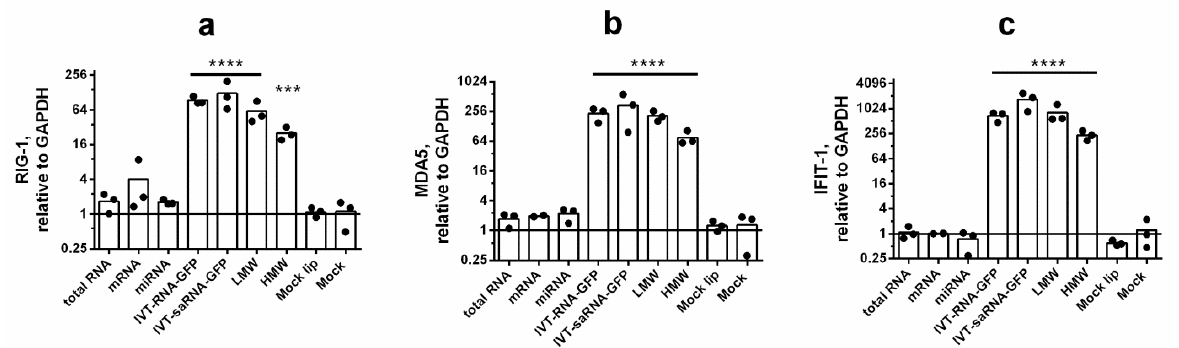
Figure 2. Synthetic RNAs are powerful activators of the IFN-mediated response. The expression levels of RIG-1 ( a ), MDA5 ( b ), and IFIT-1 ( c ) were detected at 24 h post transfection. Gene expression was analyzed via the ∆∆ Ct method (relative to GAPDH). Statistical significance ( p -value) was deter- mined by ordinary one-way ANOVA, followed by a pairwise Holm–Sidak’s multiple comparisons test: ****—adjusted p Value < 0.0001; ***—<0.001 compared to Mock. Mock—intact cells that were cultured in the same conditions and were not transfected (instead, sterile medium F12K was added). At least three biological replicates were used for each experimental data point. Data are represented as median.